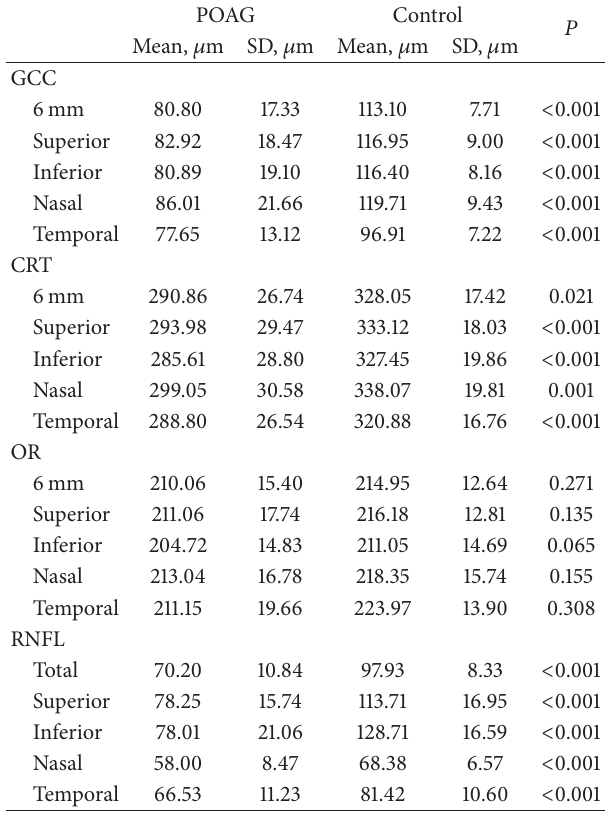
Table 3: Retinal thickness values and comparison of study subjects.